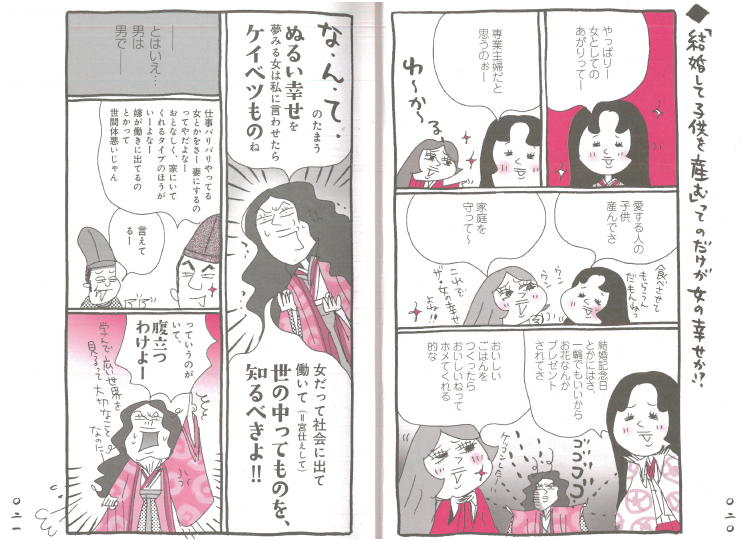
Figure 7. Sei argues for the importance for women to work outside the household. Yumiko Comukai, Honjitsu mo ito okashi Makura no sōshi (Tokyo: Kadokawa, 2014), 11. (Courtesy of Kadokawa). © Yumiko Comukai 『本日もいとをかし！！